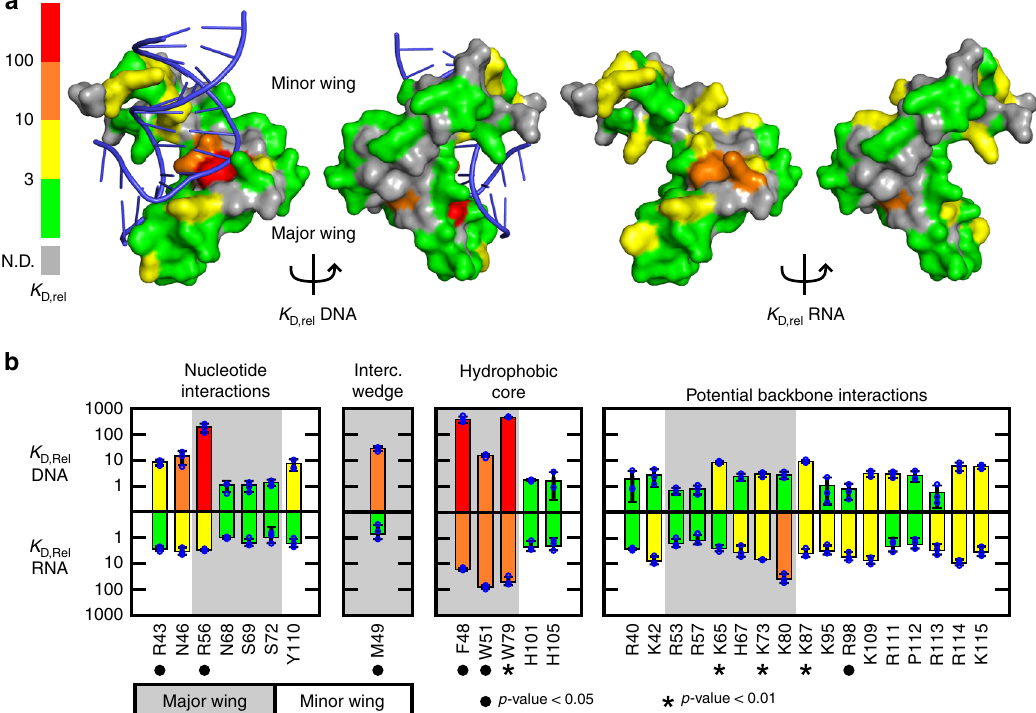
Fig. 6 Characterization of the base-speci fi c contributions to nucleic acid binding. a The relative binding af fi nities ( K D,rel ) for DNA and RNA are mapped to the Sox2-HMG surface (PDB ID 1GT0) according to the color scale to the left. b Plotted K D,rel values for DNA and RNA binding colored according to the scale in panel ( a ). The values of K D,rel are presented as the average and s.d. of n = 3 technical replicates. Bars above a gray background correspond to the Sox2-HMG major wing whereas a white background denotes the Sox2-HMG minor wing. P -values for the difference between K D,rel (DNA) and K D,rel (DNA) were calculated by the Student ’ s t -test assuming non-parametric distribution. All measured binding af fi nities and p -values for the alanine mutagenesis are provided in Supplementary Table